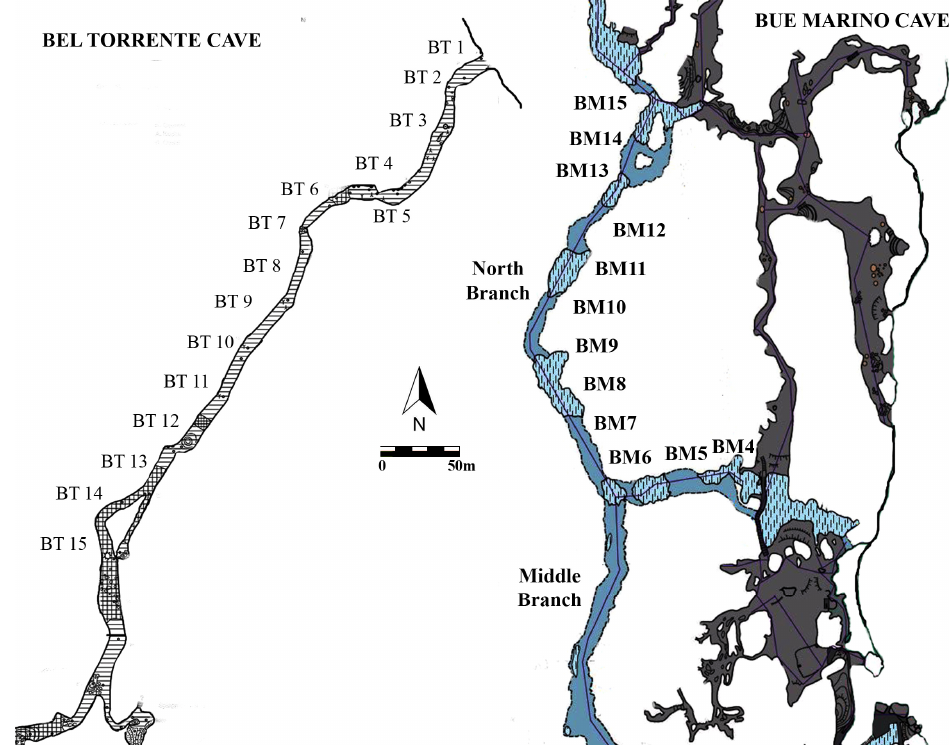
Figure 3. Sampling map of Bel Torrente (BT) from and Bue Marino (BM) caves, Sardinia, Italy [103].